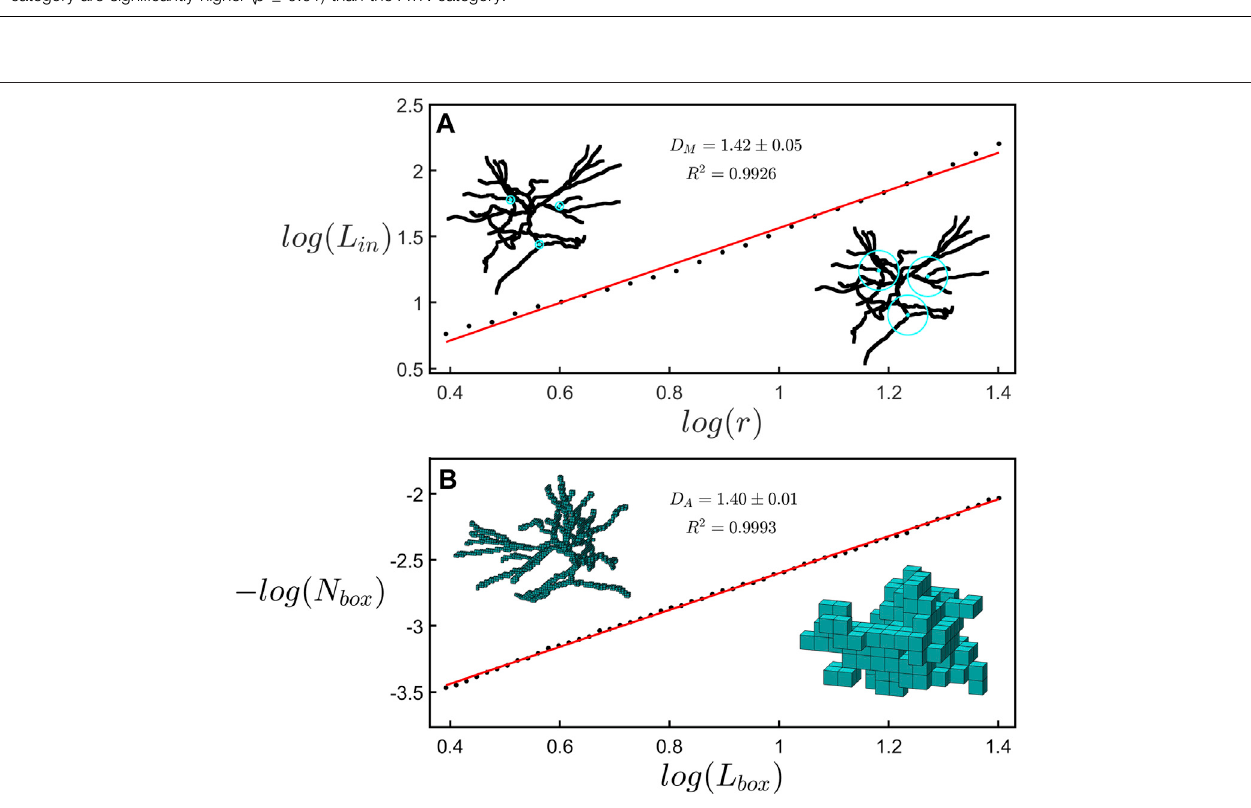
FIGURE3|(A) Ascalingplotofthecumulativelengthanalysisshowingthetotaldendriticlength, L in ,withinasphereplottedagainstitsradius r .Theleftinsetshows rings with a radius of 5 μ m at 3 example locations on a neuron while the right inset shows spheres with a radius of 25 μ m at the same locations. (B) A scaling plot of the numberofboxesoccupiedbyaneuron, N box ,plottedwithrespecttothesizeoftheboxes, L box .Theleftinsetshowsarepresentationofthespaceoccupiedbyaneuron at a box size of 3.1 μ m while the right inset shows the same neuron at a box size of 20.3 μ m.